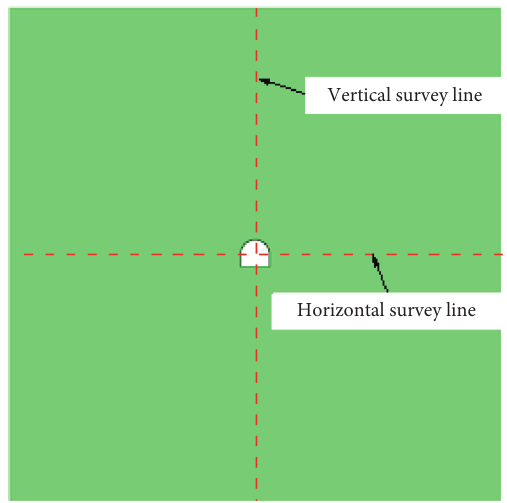
Figure 7: Layout of monitoring